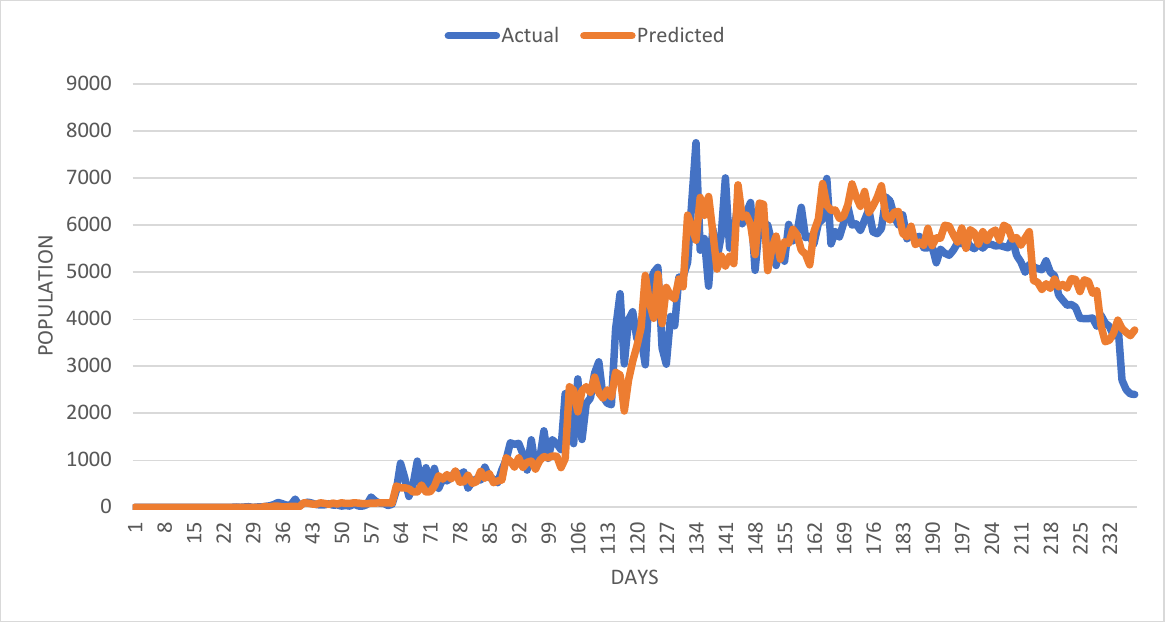
Fig. 3. Future Predicted COVID-19 Curing rate by CU model